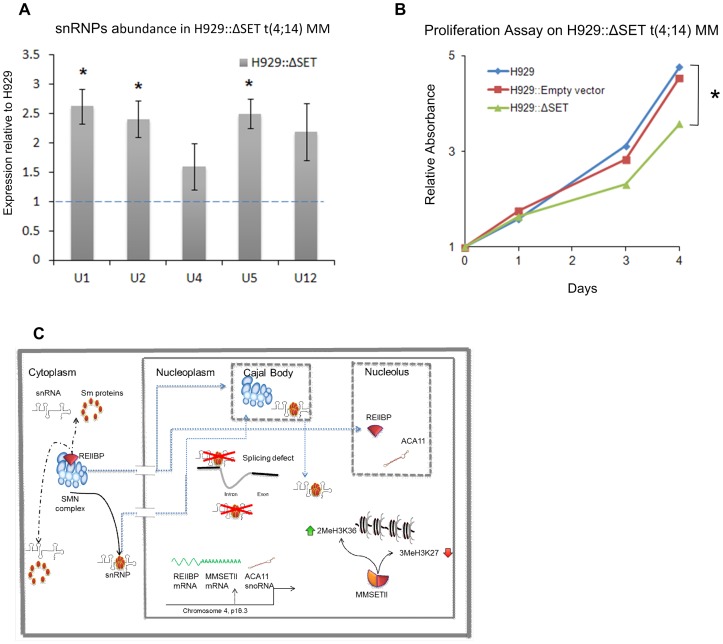
REIIBP controls snRNPs assembly and proliferation in myeloma cells.A) Cellular snRNPs abundance. snRNPs were immunoprecipitated and analysed as in Figure 3 A. Each analysis is an average of three independent IPs. Data are shown as relative to H929 values (blue dotted line). The error bars shown are the SEM. B) WST-1 proliferation assay for the indicated cells. Results represent the average of 3 independent assays. A–B) * p value <0.05. C) A schematic representation of the function and position of the MMSET gene and its products. MMSET II controls the di methylation on Lysine36 of Histone3 (2MeH3K36) and the tri methylation of Lysine 27 on histone3 (3MeH3K27) [9], [14]. Aca11 has been reported to be in the nucleolus [5], whilst the SMN complex has both cytoplasm and nucleus localization. The SMN complex is found in the nucleus at level of Cajal bodies or in the gem bodies. REIIBP and the SMN complex are likely to interact in the cytoplasm. REIIBP catalytic activity, possibly on the SMN complex, affects the number of spliceosome snRNPs particles causing splicing defects. The schematic representation of the SMN complex model is based on a previously proposed model [21]. The structures for REIIBP, ACA11, MMSET II and snRNPs are arbitrary.